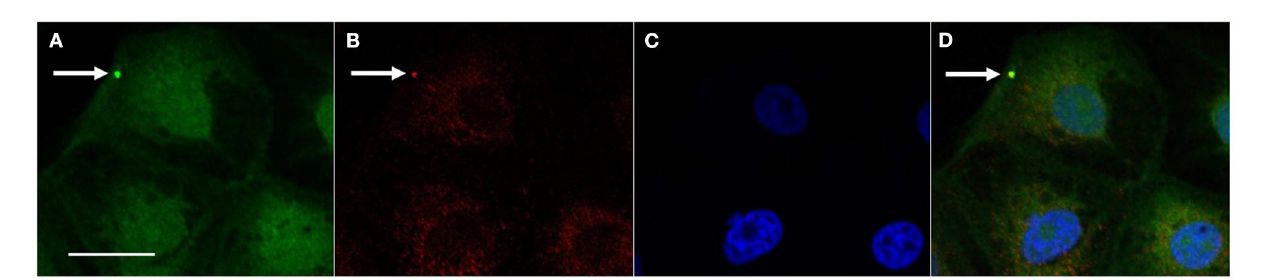
FIGURE1 Co-localization of L. intracellularis and clathrin in IPEC-J2 cells 1h after inoculation. (A) L. intracellularis fluorescent positive signal (arrow, green signal, AlexaFluor 488) and (B) Clathrin fluorescent positive signal (arrow, red signal, Cy3) were observed in the cell cytoplasm. (C) Cell nuclei (blue—DAPI) and (D) Co-localization of the fluorescent signals for L. intracellularis and clathrin (arrow, yellow signal). Confocal microscopy„ scale bar: 10 µ m.